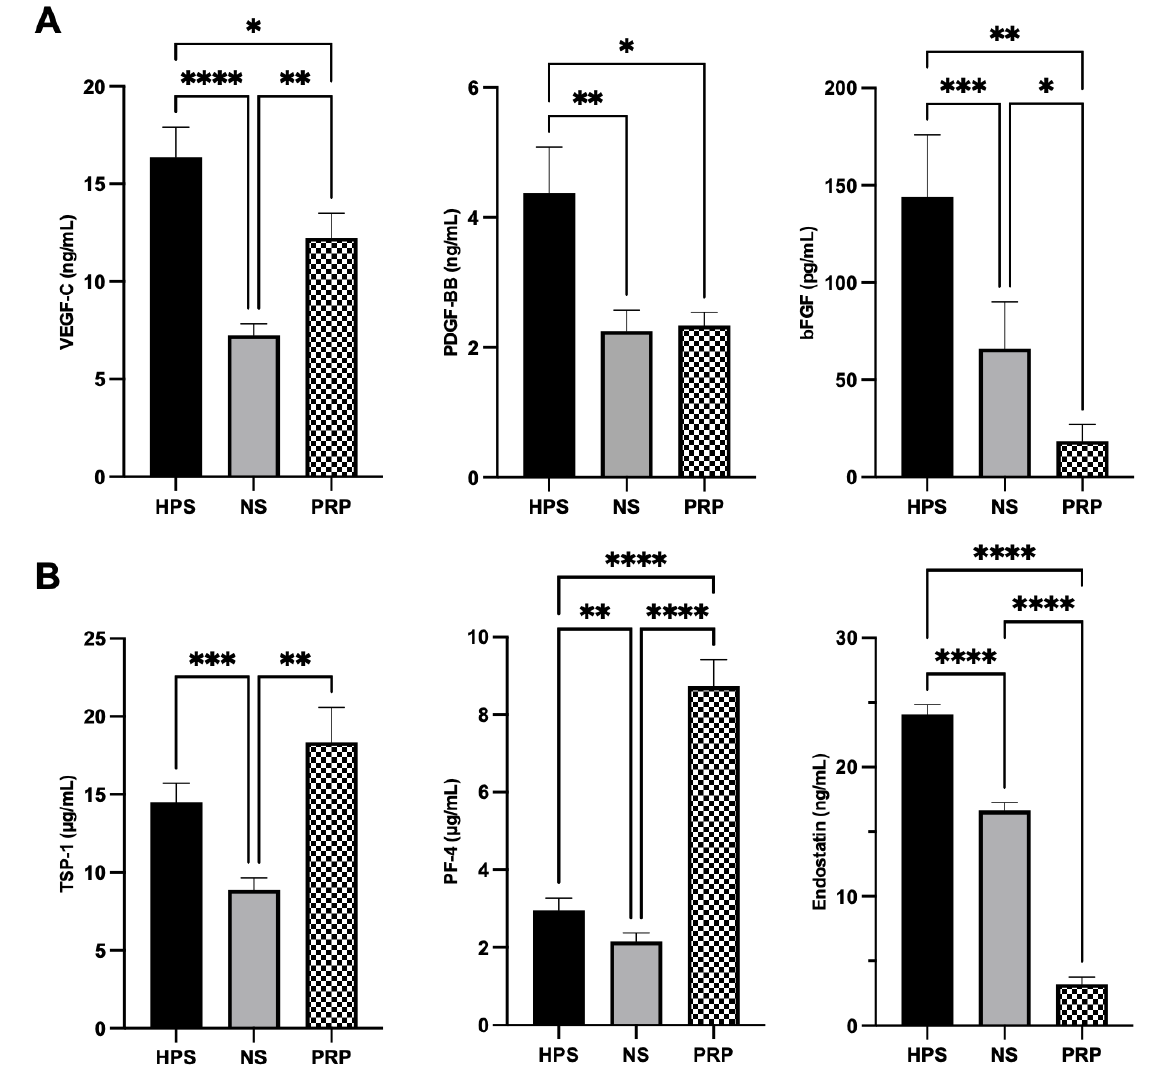
Figure 1. Quantitative analysis of pro- and anti-lymphangiogenic growth factors in HPS, NS, and PRP. ( A ) Protein quantification of the key pro-lymphangiogenic growth factors VEGF-C, PDGF-BB, and bFGF. HPS showed significantly higher VEGF-C, PDGF-BB, and bFGF levels than NS and PRP ( p < 0.05). ( B ) Protein quantification of the key anti-lymphangiogenic growth factors TSP-1, PF-4, and endostatin. One-way repeated-measures ANOVA with Tukey’s multiple comparison test. Data points are means ± SEM, blood donors: n = 9. * p < 0.05, ** p < 0.01, *** p < 0.001, **** p < 0.0001.